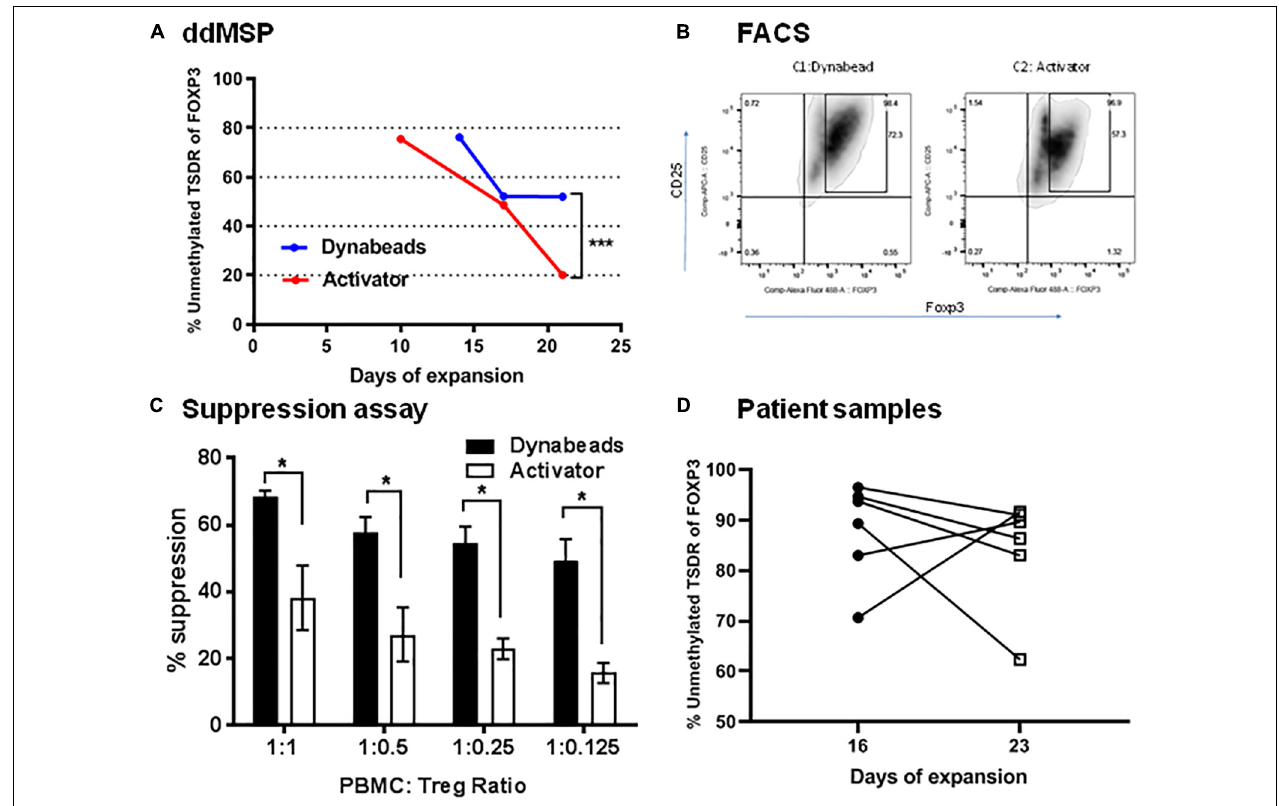
FIGURE 7 | Validation of ddMSP assay. Human PBMCs were enriched with anti-CD3 and then sorted into CD4 + CD25 high CD127 low Tregs by FACS. Sorted nTregs expanded by Dynabeads or activator in the presence of human IL-2. (A) Percentage of unmethylated TSDR of FOXP3 for expanded nTregs at 10, 14, 17 and 21 days of expansion. Statistical analysis using Wilcoxon matched-pairs rank test shows the significance between Dynabeads and activator (*** p < 0.001). The data shown are the average with SD of three repeats. (B) Representative FACS plots gated on CD4 T cells indicate the percentage of CD4 + CD25 + Foxp3 + T cells at day 21. (C) Suppression assay. CFSE-labeled PBMCs were co-cultured with Dynabeads or activator-expanded nTreg from the same donor at various ratios. The cells were stimulated with anti-CD3/anti-CD28 Dynabeads for 3 days, and the proliferation of CFSE-labeled CD8 + T cells was analyzed by FACS. Statistical analysis using two-way ANOVA shows the significance between Dynabeads and activator (* p < 0.05). The data shown are the average with SD of three repeats. (D) Quantification of the percentage of unmethylated TSDR of FOXP3 in expanded Treg cells after 16 and 23 days of expansion using the ddMSP assay. The data shown are the average with standard deviation (SD) obtained from six different donors and three repeats.